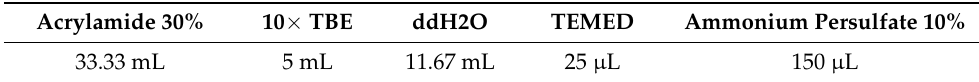
Table 2. PAGE gel